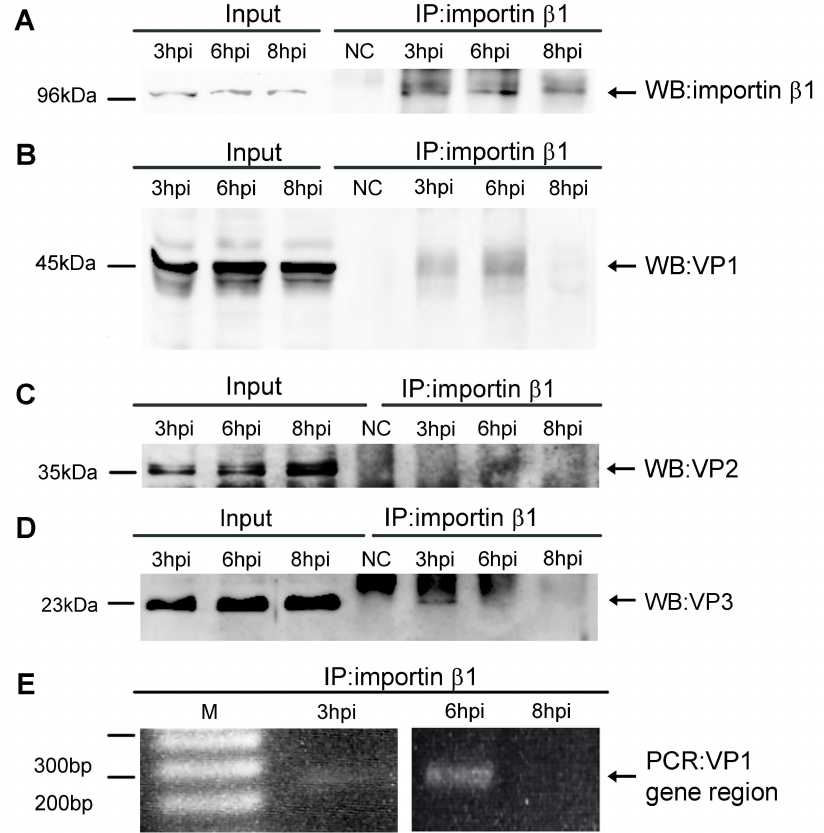
Figure 1. In vivo interactions between importin β 1 and viral particles at early times post infection. Western blots of 3T6 cell lysates (labeled as Input) or complexes precipitated through antibody against importin β 1 (labeled as IP) were performed with antibody against importin β 1 ( A ), VP1 ( B ) or VP2/VP3 ( C , D ). As a negative control (NC), samples precipitated through nonspecific anti-mouse IgG were used. The viral DNA was isolated from complexes and amplified by PCR at indicated times post infection ( E